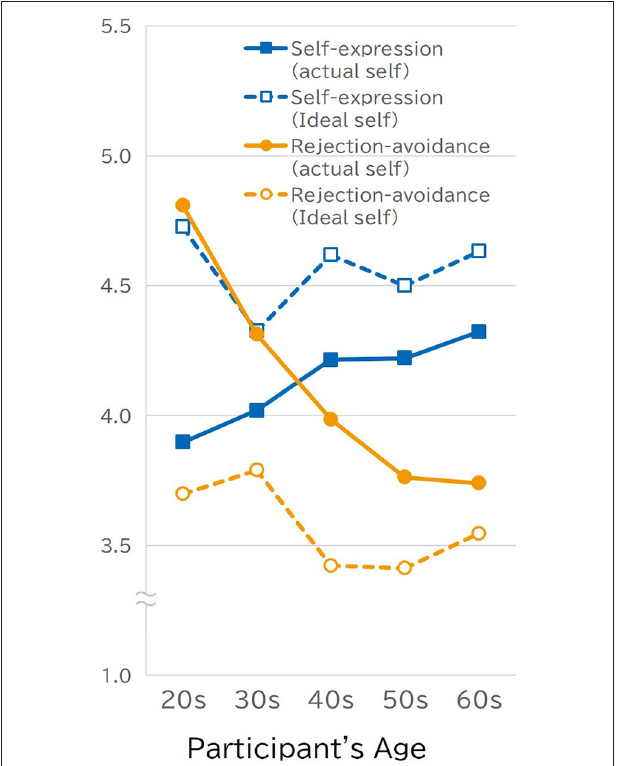
FIGURE 2 | Relationships between the participants’ actual-self and ideal self scores on the self-expression/rejection-avoidance scales and their age (Study